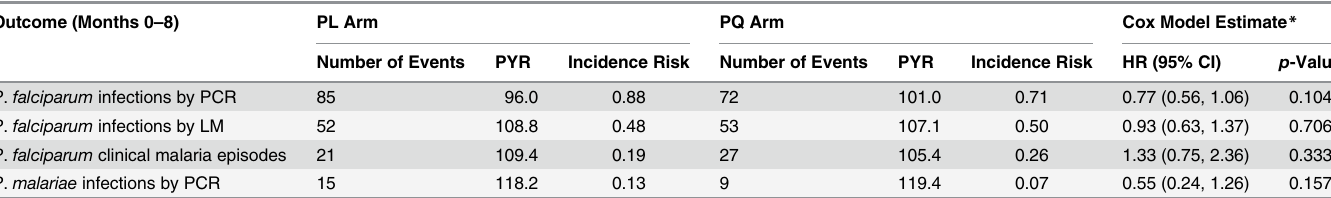
assumed to clear blood- and liver-stage infections and provide 8 wk of causal prophylactic pro- tection (for full model details please refer to S1 Table). Fig 6 illustrates the predicted qualitative dynamics of P . falciparum and P . vivax transmission following two rounds of MDA (Fig 6A and 6B) or MSAT (Fig 6C and 6D) interventions with 80% coverage, separated by 6 mo. The interventions are predicted to cause a sharp decline in prevalence, followed by a gradual return to pre-intervention levels. MDA is predicted to achieve much larger reductions in prevalence than MSAT, mostly due to the proportion of infections missed by the MSAT programme because of imperfect diagnos- tic sensitivity, but also because of the prophylactic protection in treated but uninfected individ- uals under the MDA programme. Table 4. Incidence of first (or only) P . falciparum/P . malariae re-infection and P . falciparum clinical malaria in treatment groups in the entire fol- low-up period. Outcome (Months 0 –